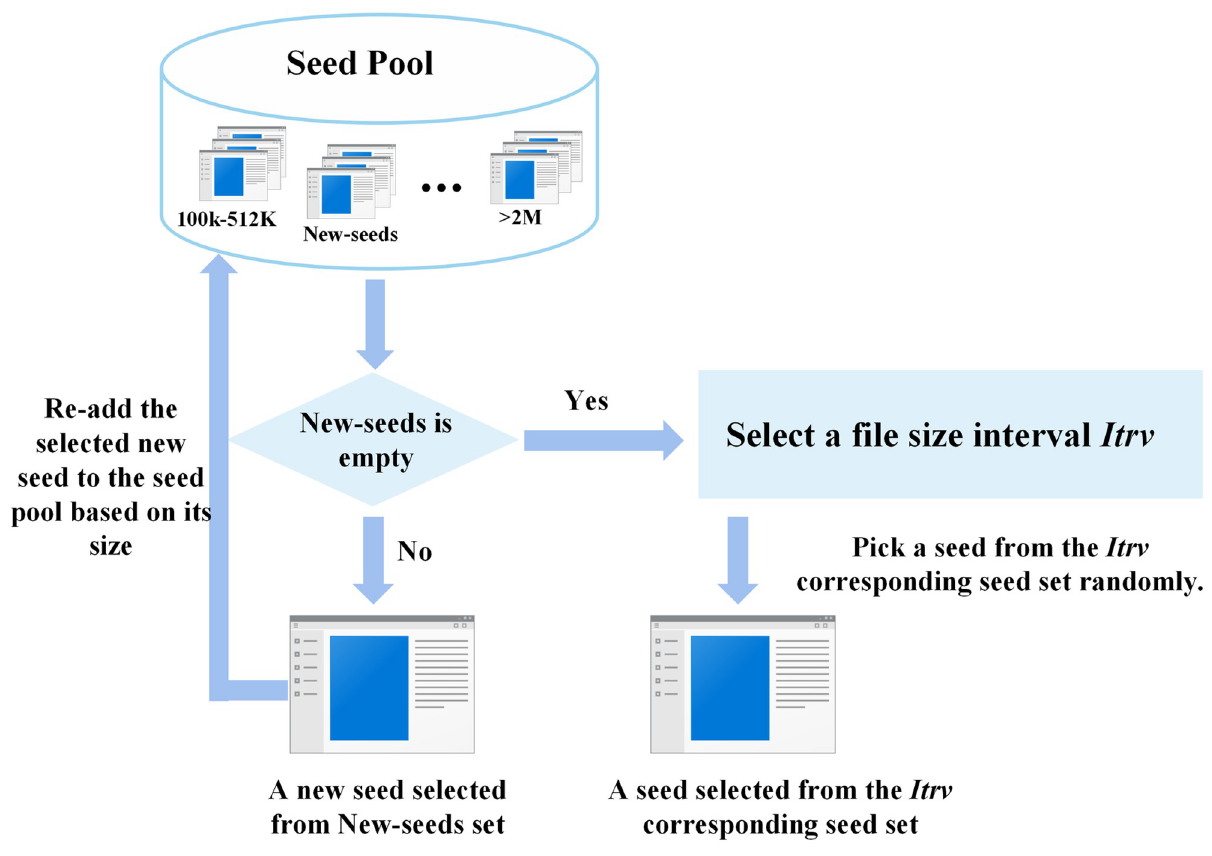
Fig 2. Seed selection strategy.